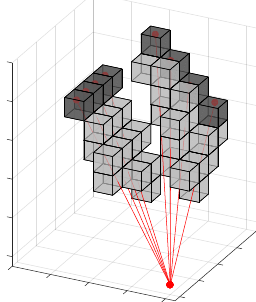
Figure 3. Schematic diagram of the probability map.